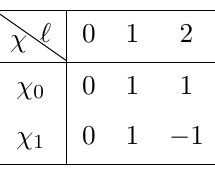
Table 2 . The two Dirichlet characters modulo